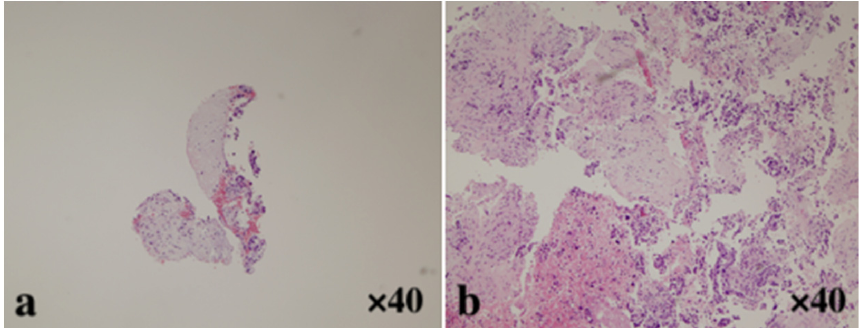
Figure 4. Comparison of histological sample volumes among various needles ( a ) A small amount of fragmented specimen obtained using 22-gauge FNA needles (H and E, × 40), which makes it difficult to diagnose adenocarcinoma. ( b ) A core tissue including the desmoplastic fibrosis with neoplastic cellular elements obtained using a 19-gauge FNB needle (H and E, × 40). This sample was obtained in sufficient quantity for genetic panel profiling testing for pancreatic cancer (OncoGuide TM NCC Oncopanel system, Sysmex Corporation, Hyogo, Japan).